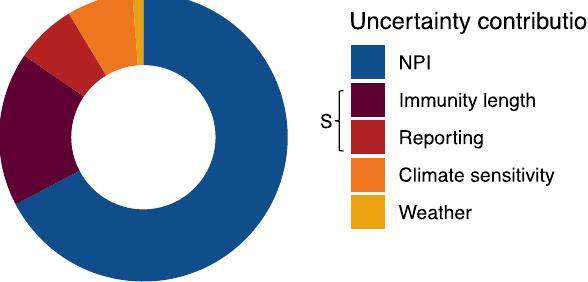
Fig. 4 Contribution to uncertainty in New York wintertime 20/21 peak size. The relative importance of NPI ef fi cacy [0 – 35%], immunity length (10 – 60 weeks), reporting (1 – 100%), climate sensitivity of the virus [ − 32.5